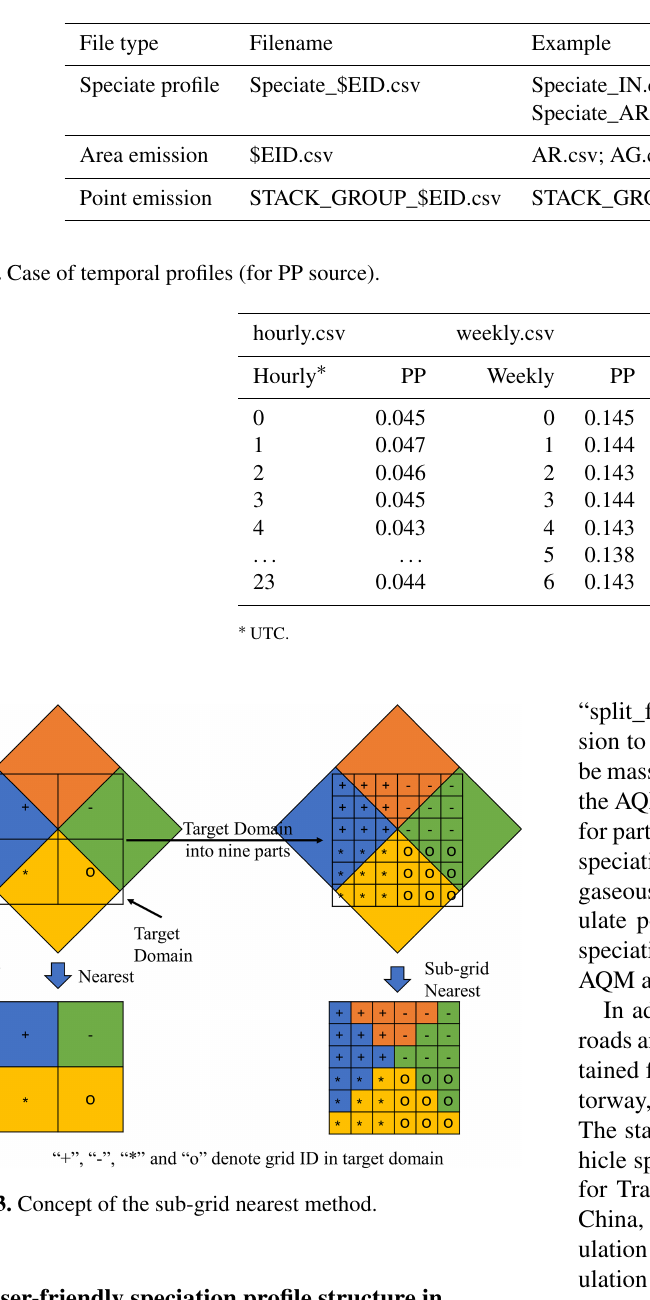
Table 1. File structure defined by emission source sector ID (EID).